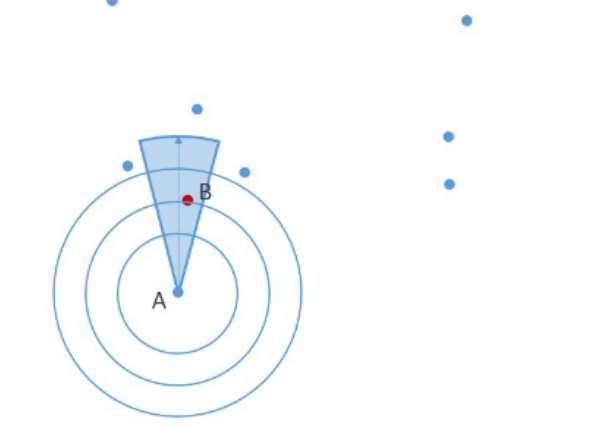
Figure 4. An example of the backtracking point B of the target A.